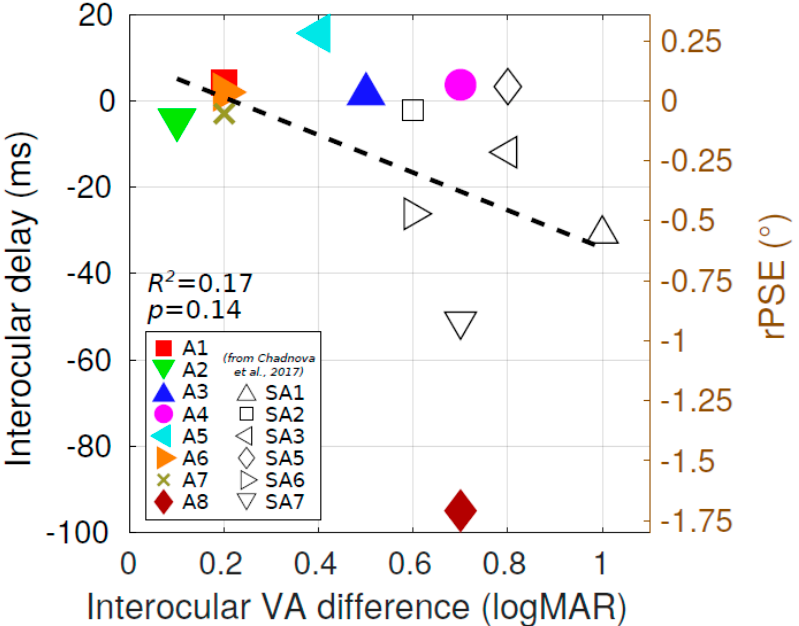
Figure 8. Correlation between interocular delay and interocular visual acuity (VA) difference in the amblyopic population. The delay observed in the amblyopic eye is plotted as a function of the difference in VA between the non-amblyopic eye (NAE) and the amblyopic eye (AE) for mild (filled color symbols) and strong (open black symbols) amblyopes. Data for strong amblyopes were taken from Reference [38]. The dashed line represents linear regression across the full population (coefficient of determination R 2 = 0.17, p = 0.14; excluding subject A8: R 2 = 0.22, p = 0.11).